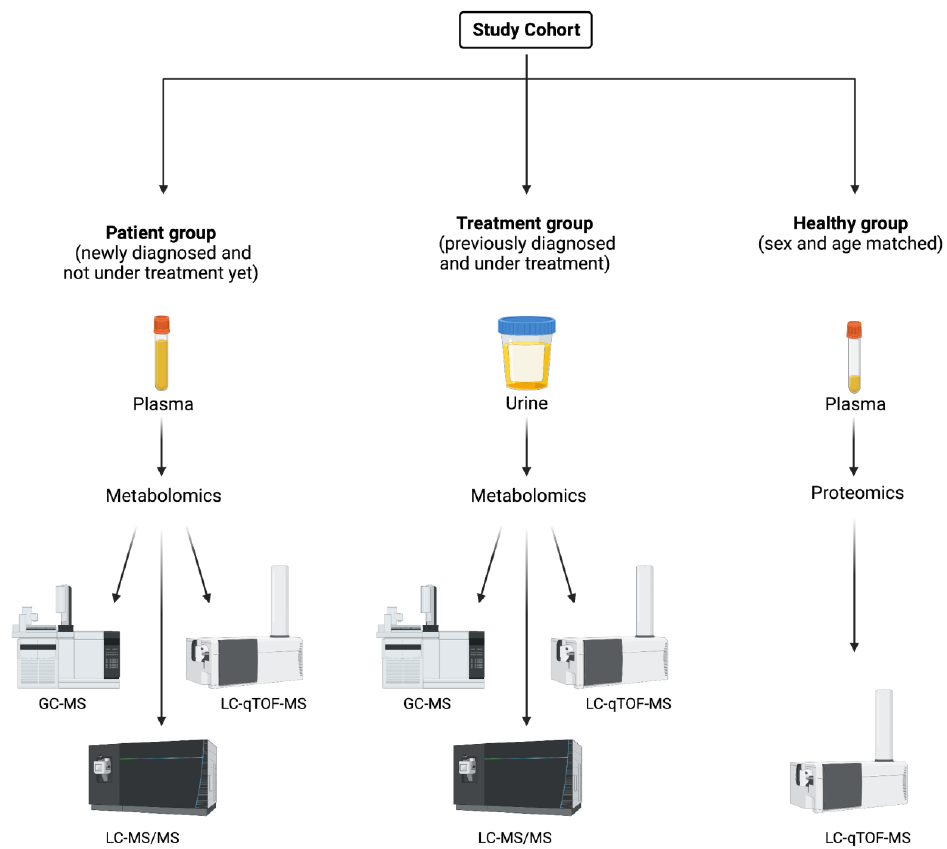
Figure 4. Study cohort and multi-omics analyses were performed on multiple biological specimens using multiple analytical techniques.